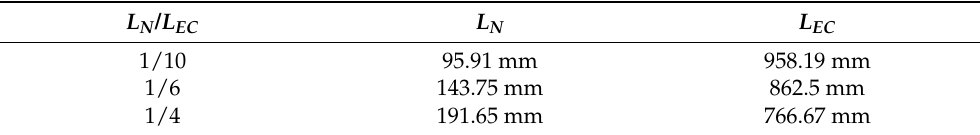
Table 4. Parameters of S N and S EC of the ITECs in Figure 8.